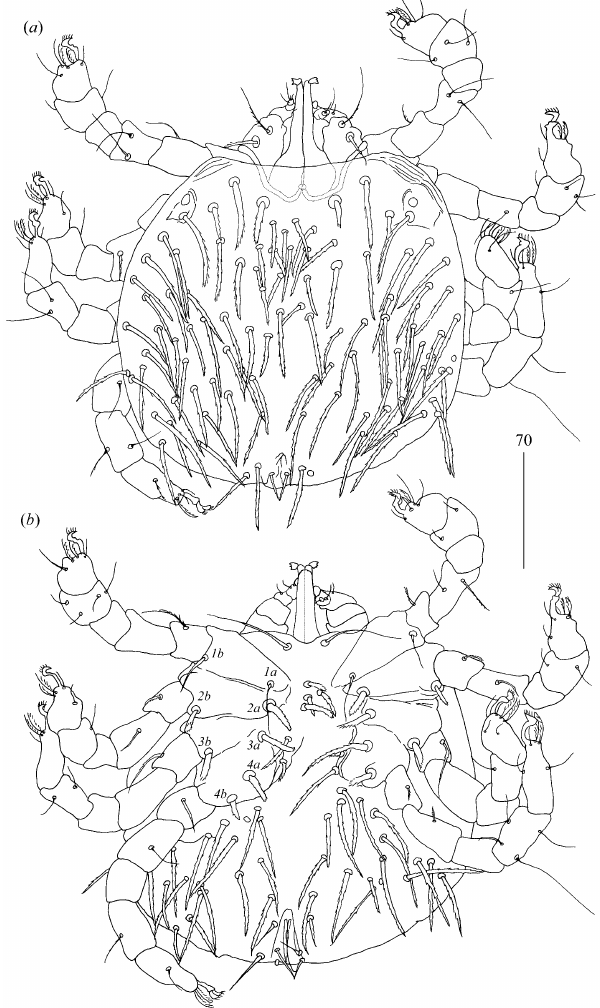
Figure 10. Geckobia mysoriensis sp. n. protonymph: ( a ) in dorsal view; ( b ) in ventral view.